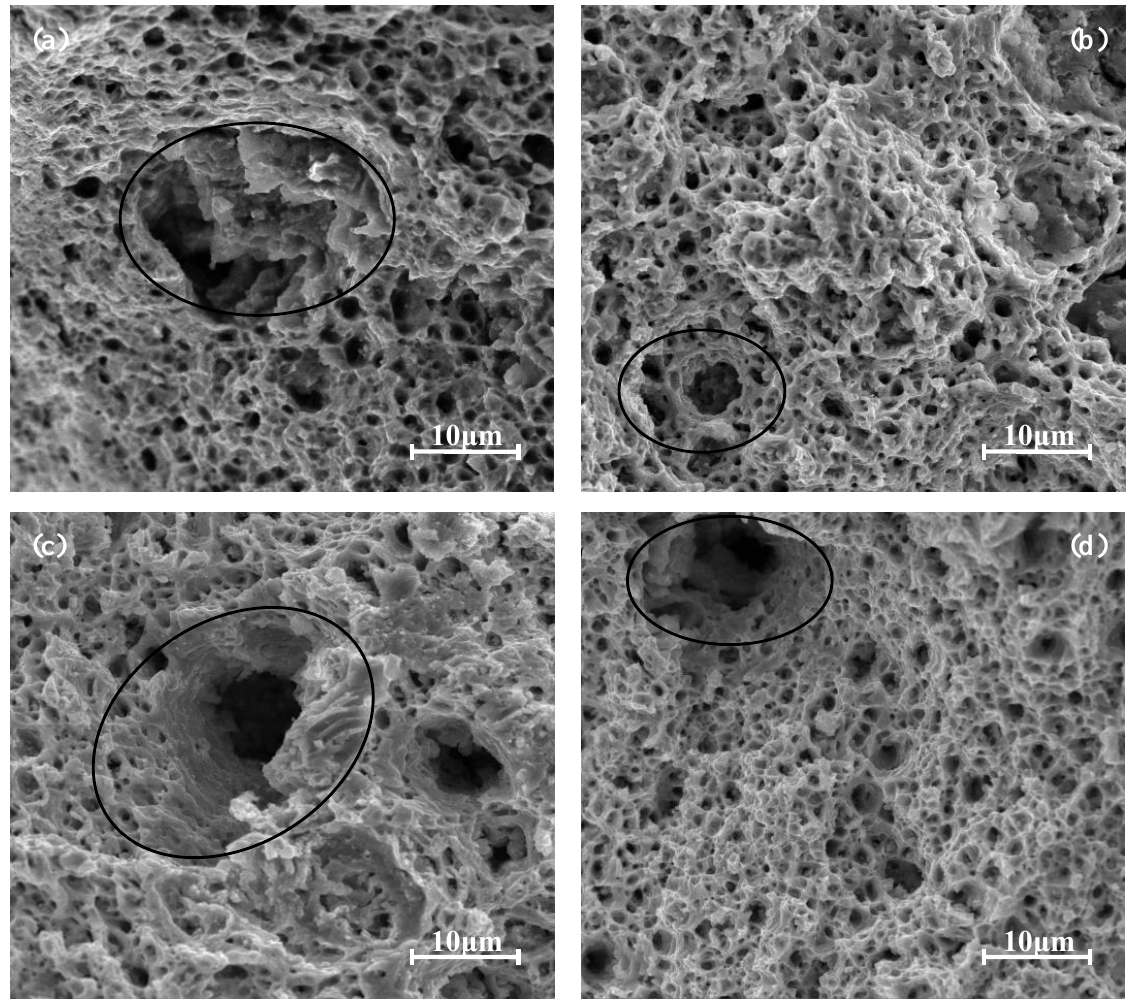
Figure 6: Fracture morphology of AgSnO 2 NiO after extrusion and drawing × 5000 (a) 1 # sample AgSnO 2 (5)NiO(0.5); (b) 2 # sample